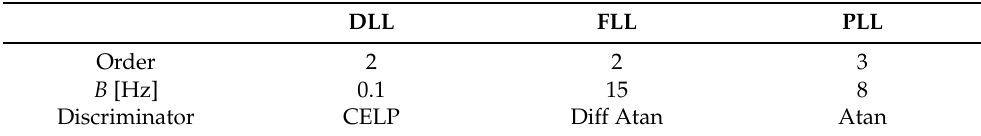
Table 4. Initial configuration of the DLL, FLL and PLL for each tracking channel.